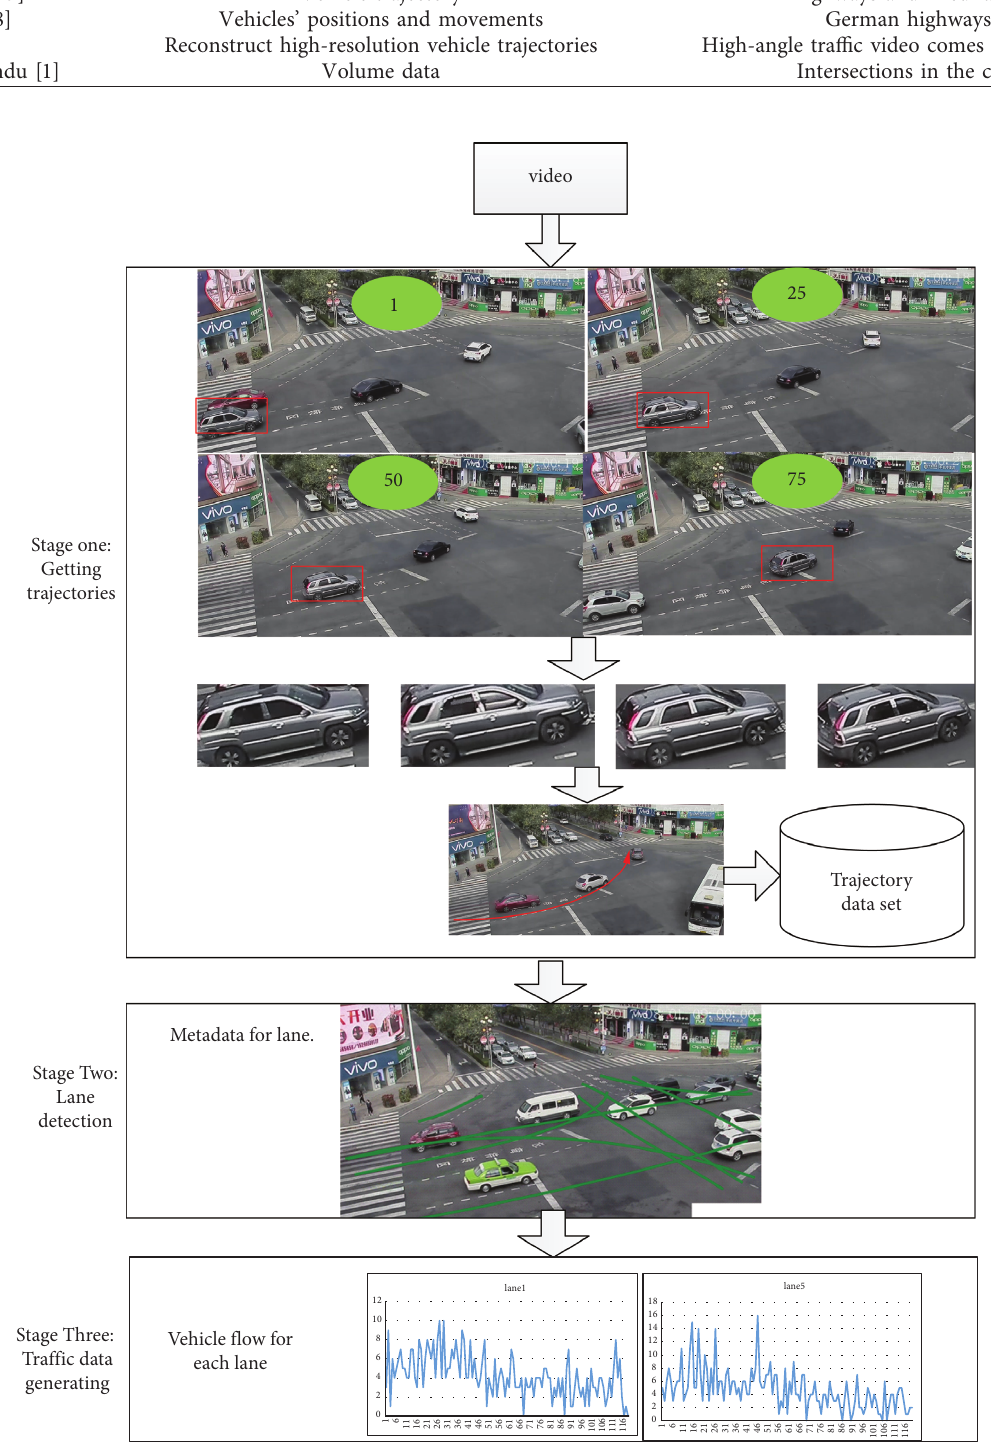
Figure 2: The process of big traffic data generating.